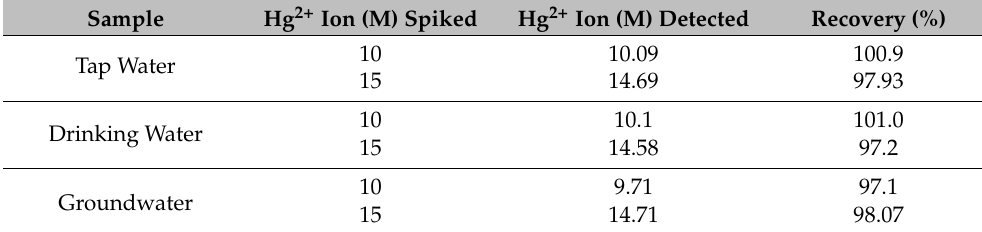
Table 1. Determination of Hg 2+ ions in water